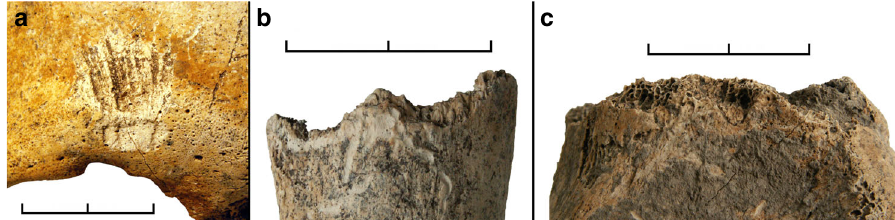
Fig. 6 Examples of animal damage to the bones from the mass grave. a Typical rodent gnawing damage above the right orbit in the skull of ind. 7. b Carnivore gnawing damage to the distal right tibia in ind. 3, partly overlain by root etching. c Carnivore gnawing damage to the proximal left tibia in ind. 2. Scale bar length is 2 cm